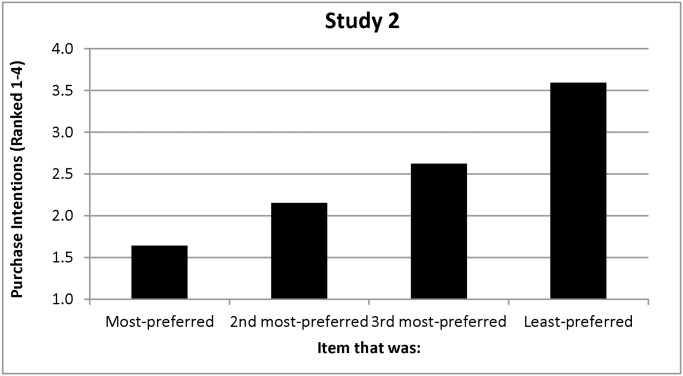
Purchase Intentions as a Function of Preferences in Study 3.